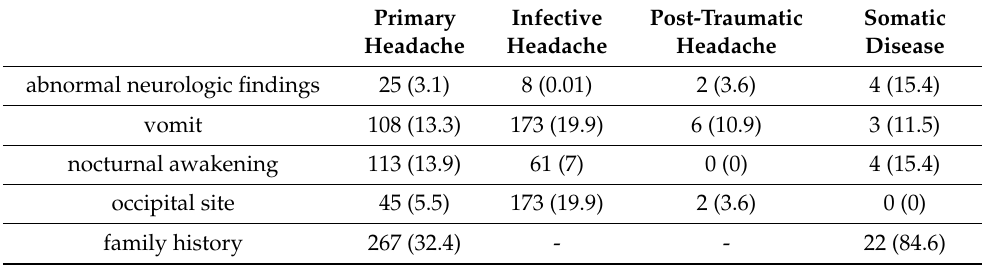
Table 3. Frequency of red flags in patients with different types of non-life-threatening headaches. Primary Infective